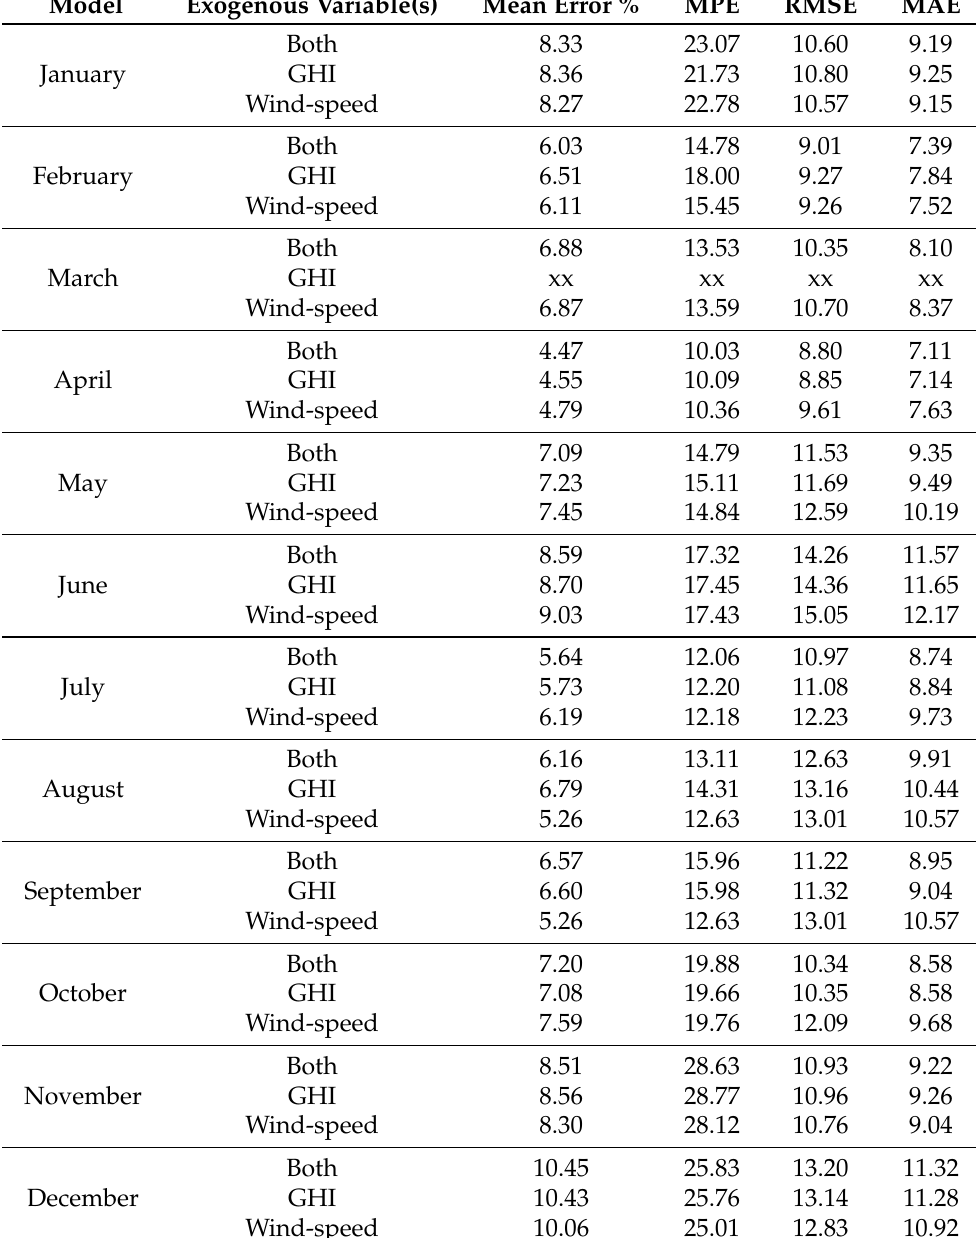
Table 8. Sensitivity Analysis of contribution of each variable. “Both” indicates GHI and wind-speed used